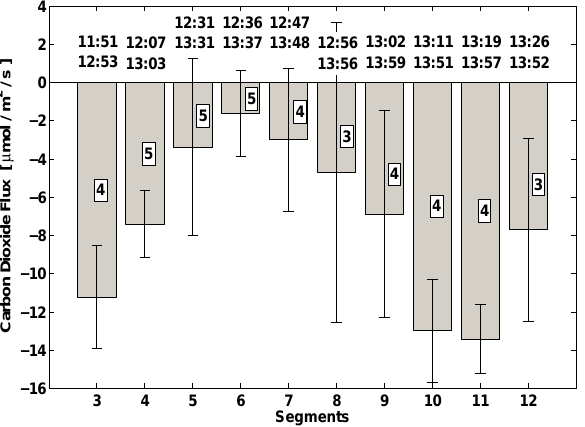
Fig. 9. Average carbon-dioxide flux per segment along flight track during IOP1 (18–22 April) at CERES’07, where negative values mean carbon uptake. In addition, error bars (= standard deviation of single passes), time periods (UTC=LT − 2) and the amount of flights it is based upon (numbers in boxes) are depicted for each segment.